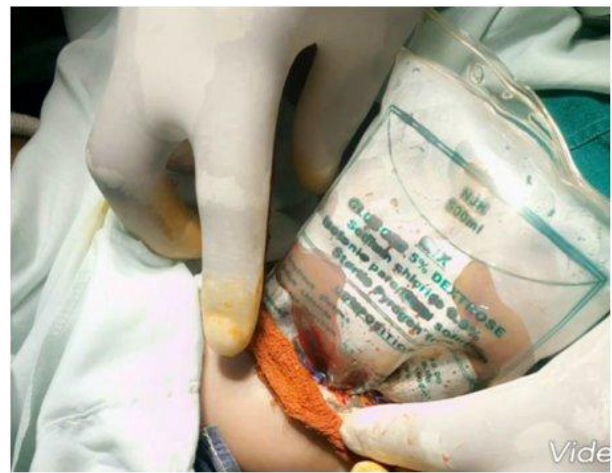
Figure 3: Betadine dressing over the skin